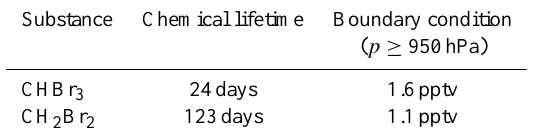
Table 2. Chemical lifetime and boundary condition of CHBr 3 and CH 2 Br 2 in the idealized chemical tracer experiment.